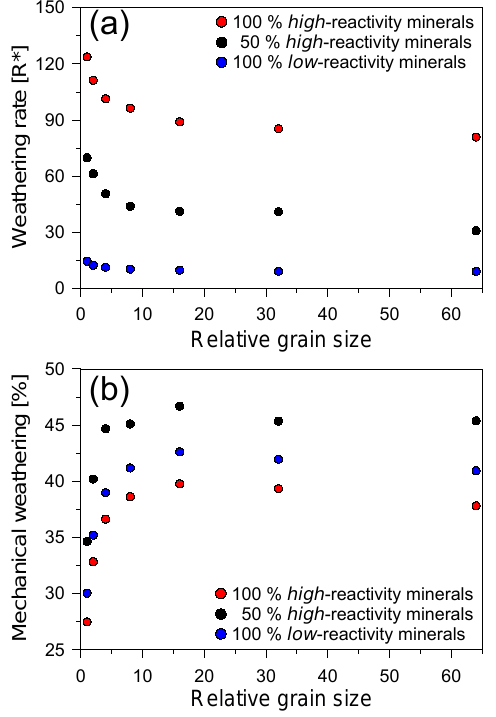
Figure 3. Effect of grain size on weathering for three different com- positions: (a) weathering rate versus relative grain size in units of R ∗ and (b) the ratio of mechanical weathering to overall weather- ing versus relative grain size. Red circles represent simulations for a rock comprising 100% high-reactivity mineral phase. Black circles represent an equal mix of high- and low-reactivity mineral phases. Blue circles represent a rock comprising 100% low-reactivity min- eral phases. Weathering rate decreases strongly with relative grain size until a plateau is reached at larger grain sizes. Similarly, the me- chanical contribution also increases with increasing grain size until a plateau is reached.